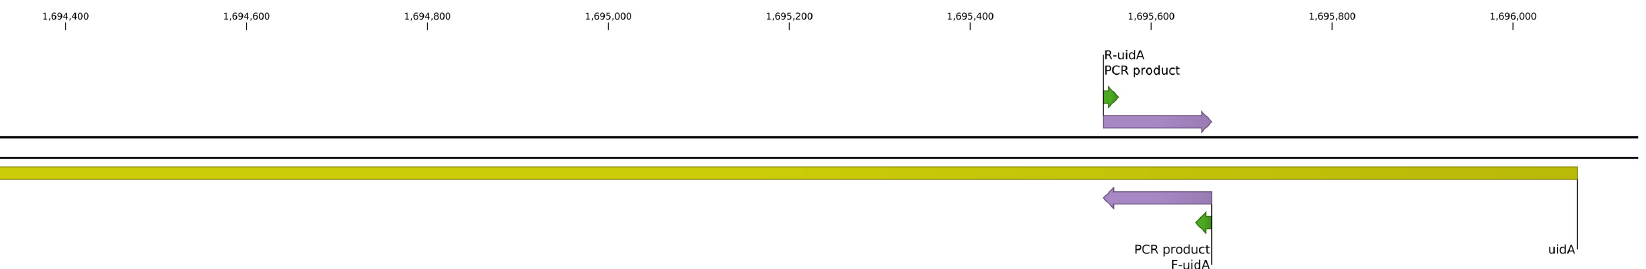
Figure 3. Genomic positioning of the primer binding sites in the E. coli K12 substr. MG1655 genome (NC_000913). Green arrows indicate the primer binding sites, purple arrows indicate the two strands of the PCR product (genomic position: 1,695,547–1,695,667 bp), yellow arrow show the genomic position of uidA gene and the black lines are the two strands of the genomic DNA. The scale on the top indicates the genomic positions and should be read in base pairs.